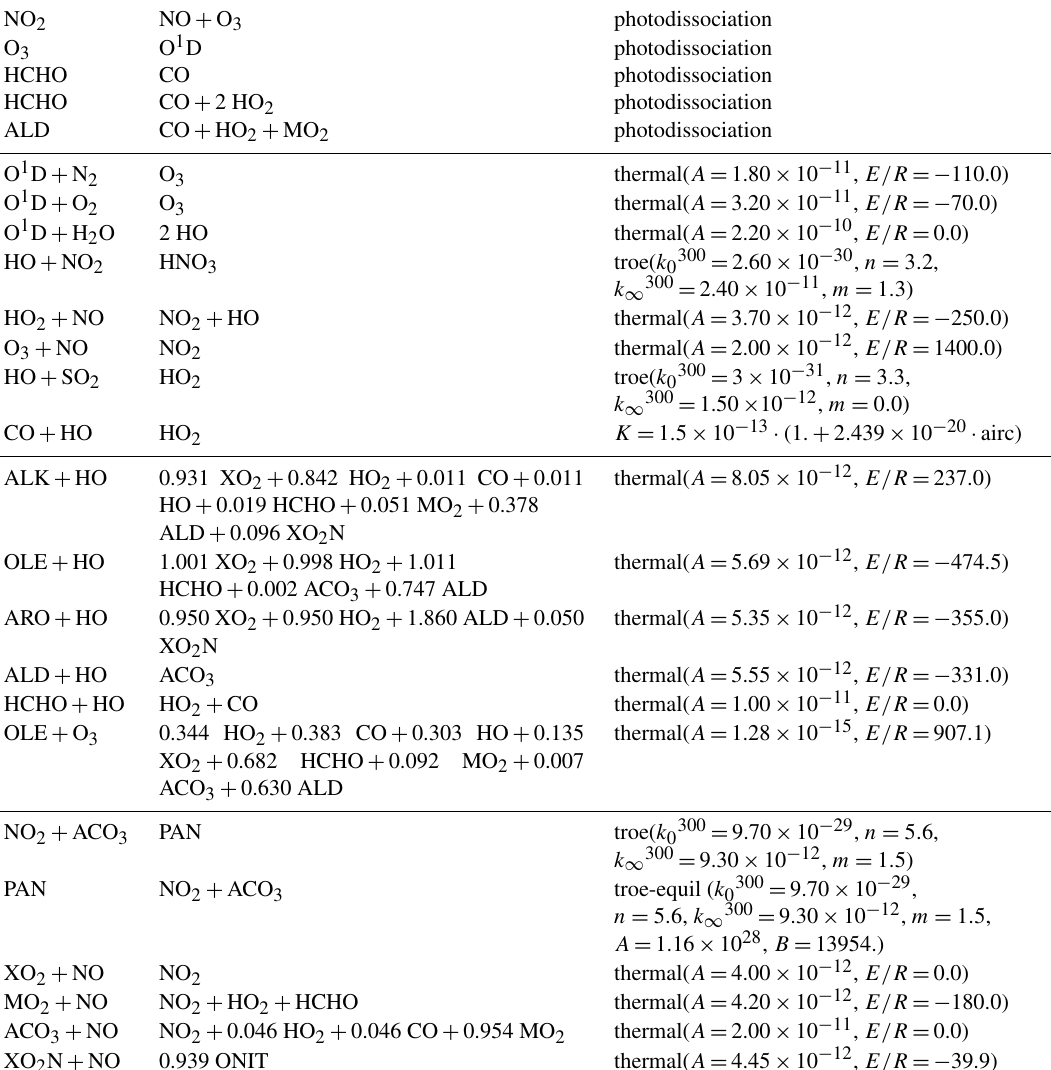
− 1 , and reactions called “Troe-equilibrium” by k = − 1 , where k 0 (T ) = k 0300 (T/ 300 ) − n and k ∞ (T ) =